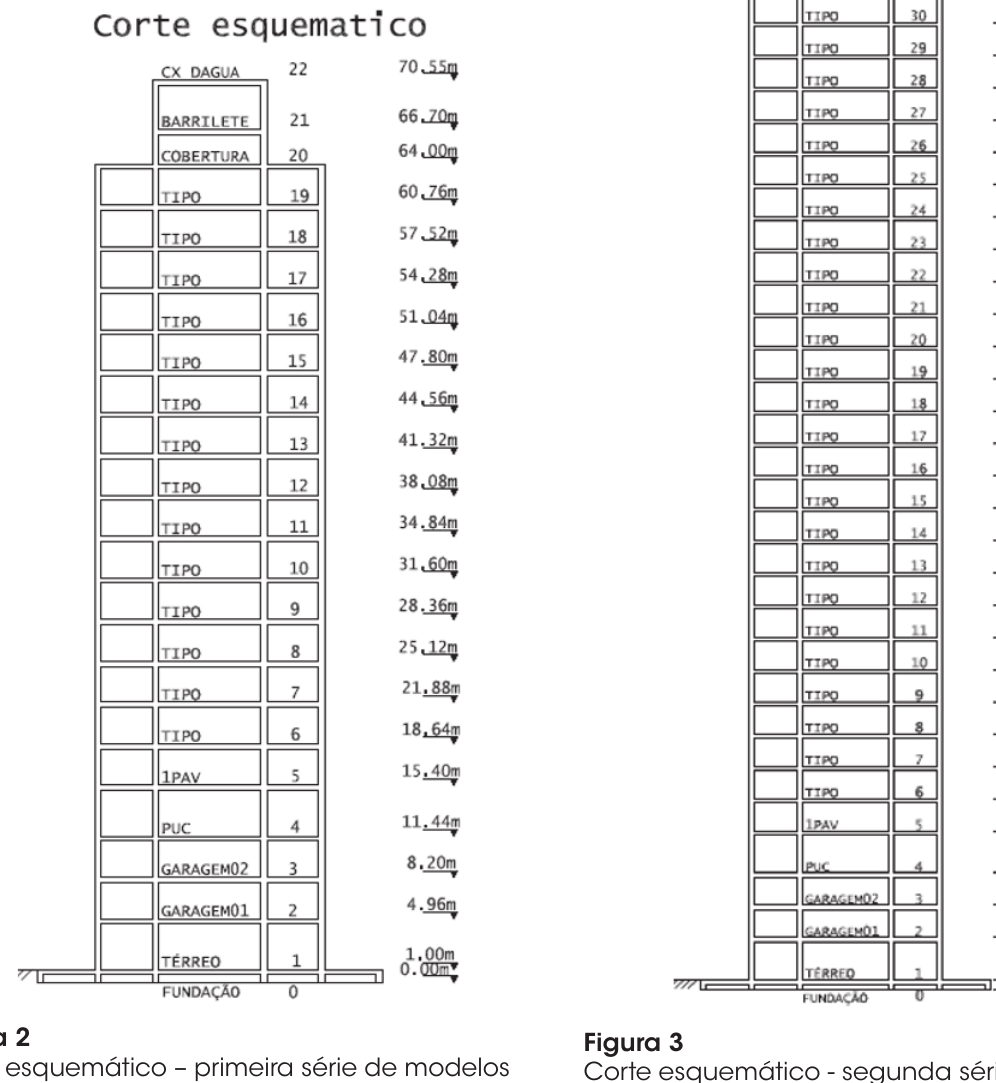
Corte esquemático – primeira série de modelos Corte esquemático - segunda série de